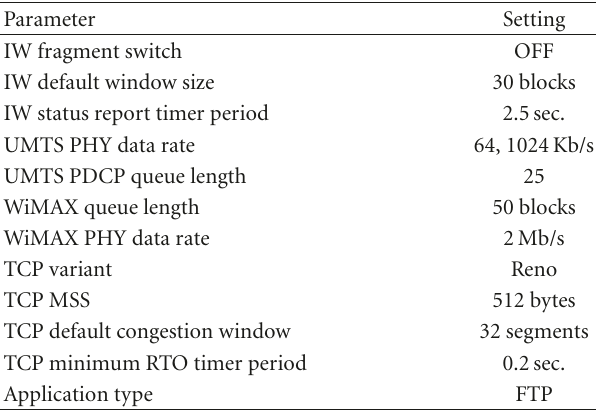
Table 1: Simulation